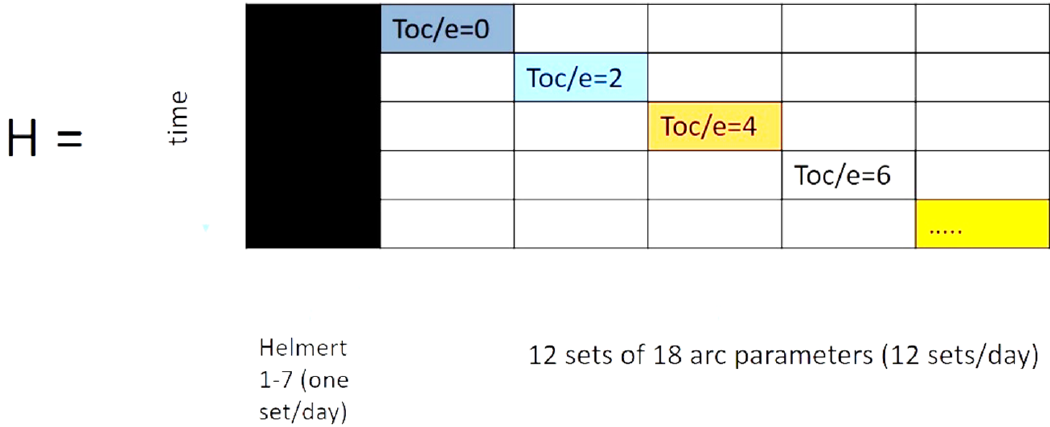
Figure 1. Schematic structure of the partial derivative matrix for the GPS-like model. The first vertical block represents the partials of XYZT pre-fit residuals relative to the Helmert parameters, appropriately scaled. The block diagonal part contains 12 blocks each of 4 rows of 18 partial derivatives, using as a priori the broadcast values of the parameters which are indexed with Toe for the coordinates and Toc for the clock.